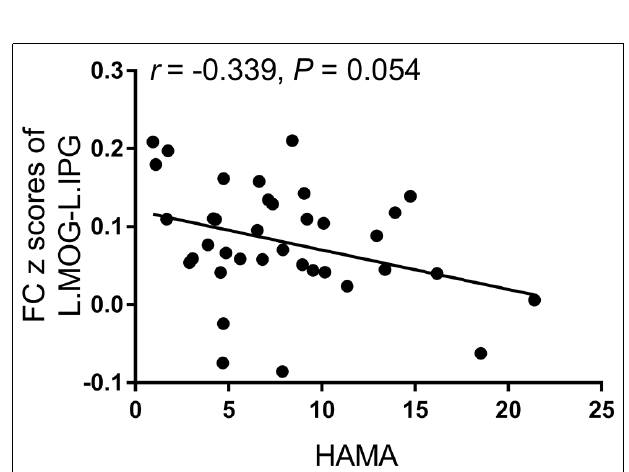
FIGURE 3 | The correlation trend between the FC z -scores of the left middle occipital gyrus-left inferior parietal gyrus and Hamilton Anxiety Scale (HAMA)